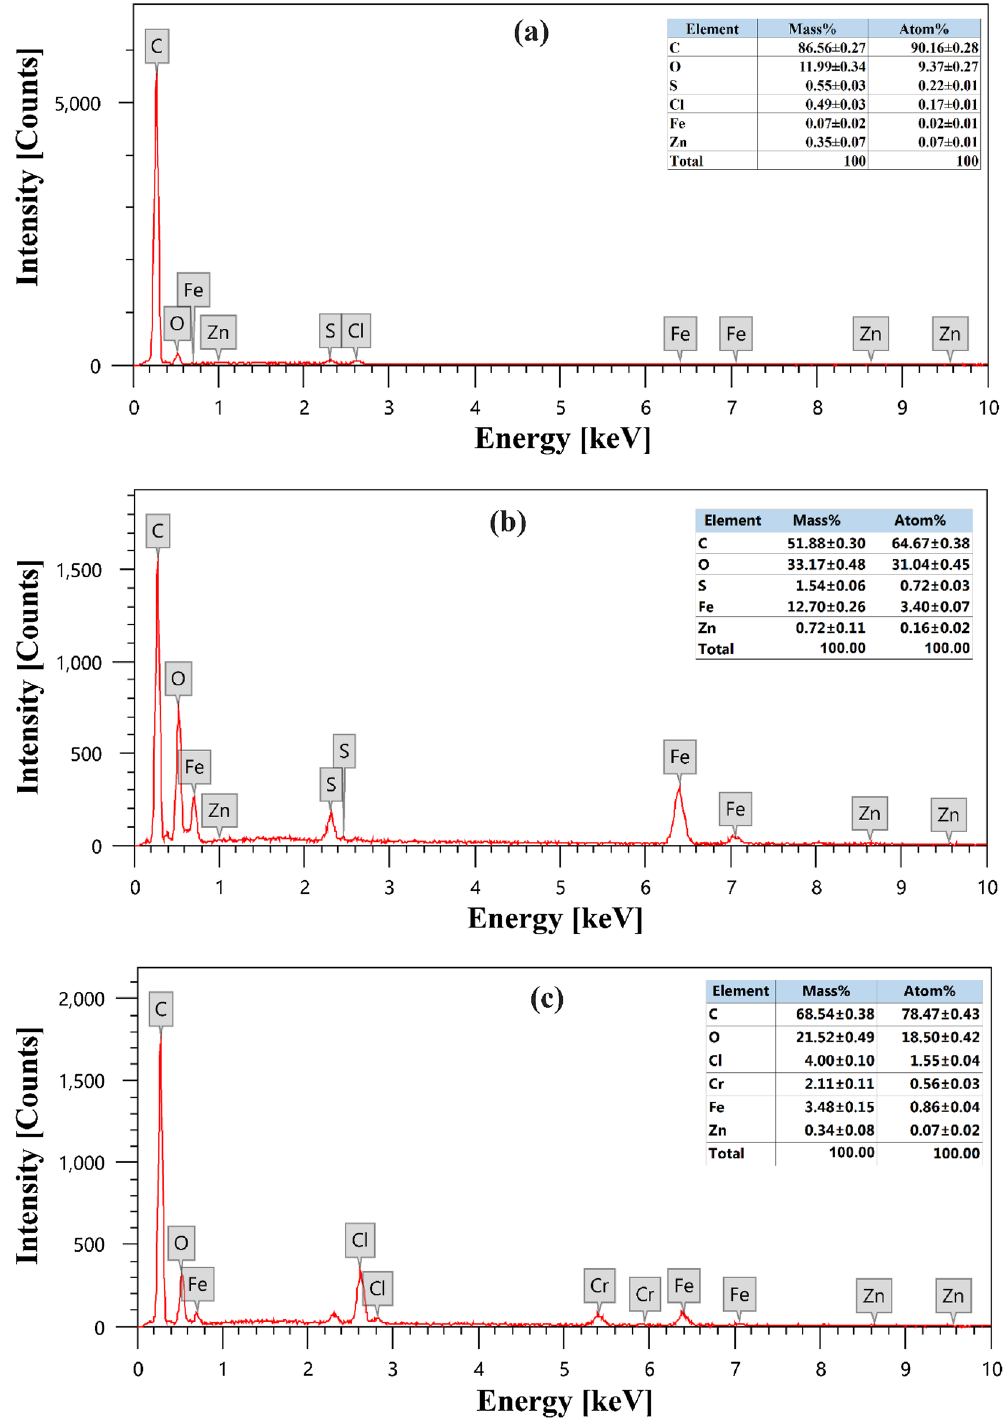
Figure 6. EDX investigation of ( a ) OPAC, ( b ) MG-OPAC composite, ( c ) Cr 6+ ions absorbed on